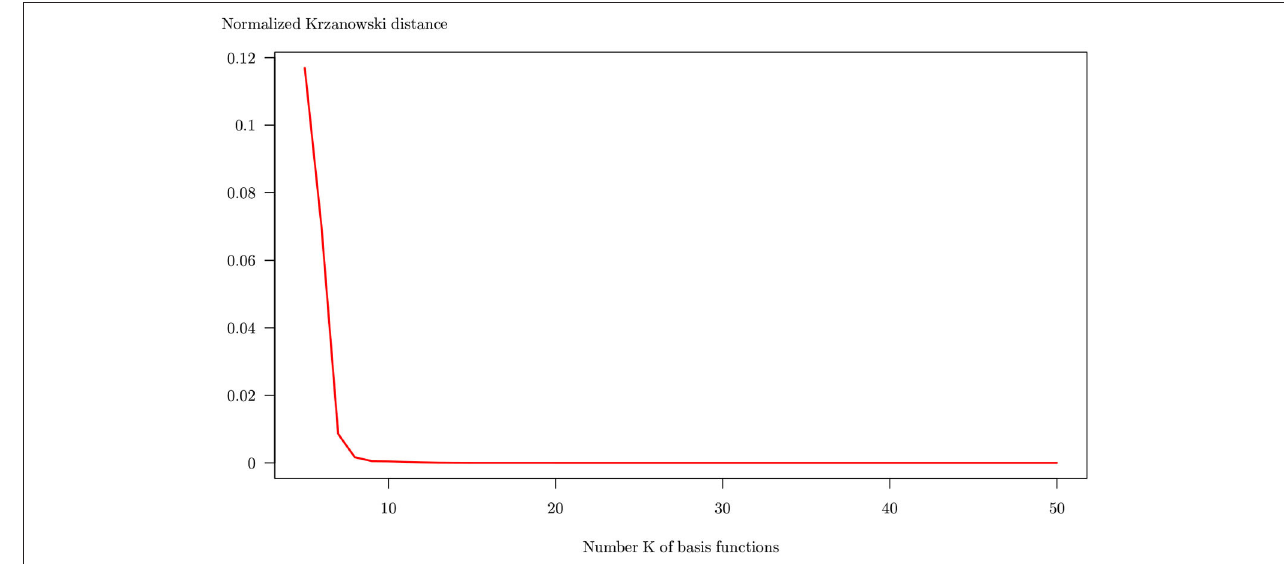
FIGURE 6 | Krzanowski distance computed between reference FPCA ( K = 50 basis functions) and FPCAs with K ranging from 5 to 50. Distances are computed using five principal components, accounting for about 90 % of the entire variability in every case.